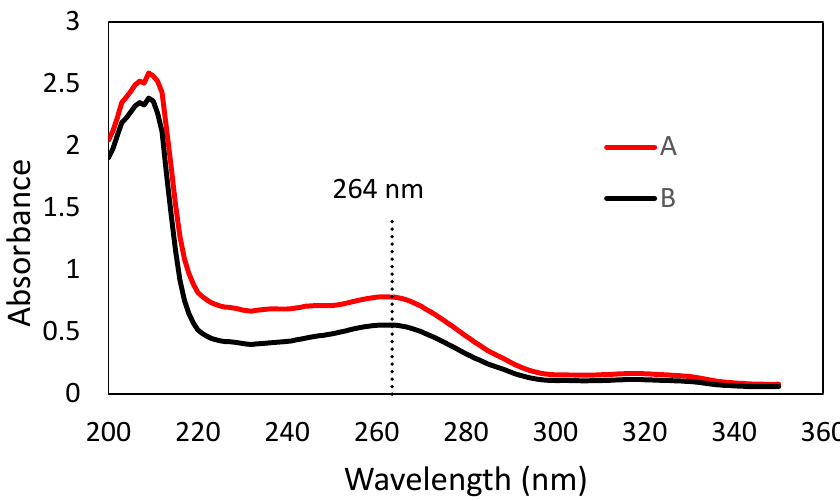
Figure 6. UV-absorbance spectra for hexane leaflet washes of BC3F5 plants obtained by two sampling methods, A and B (see text). The vertical dashed line identifies 264 nm, the λ max for isolated 7-epi zingiberene in the 250–280 nm region.